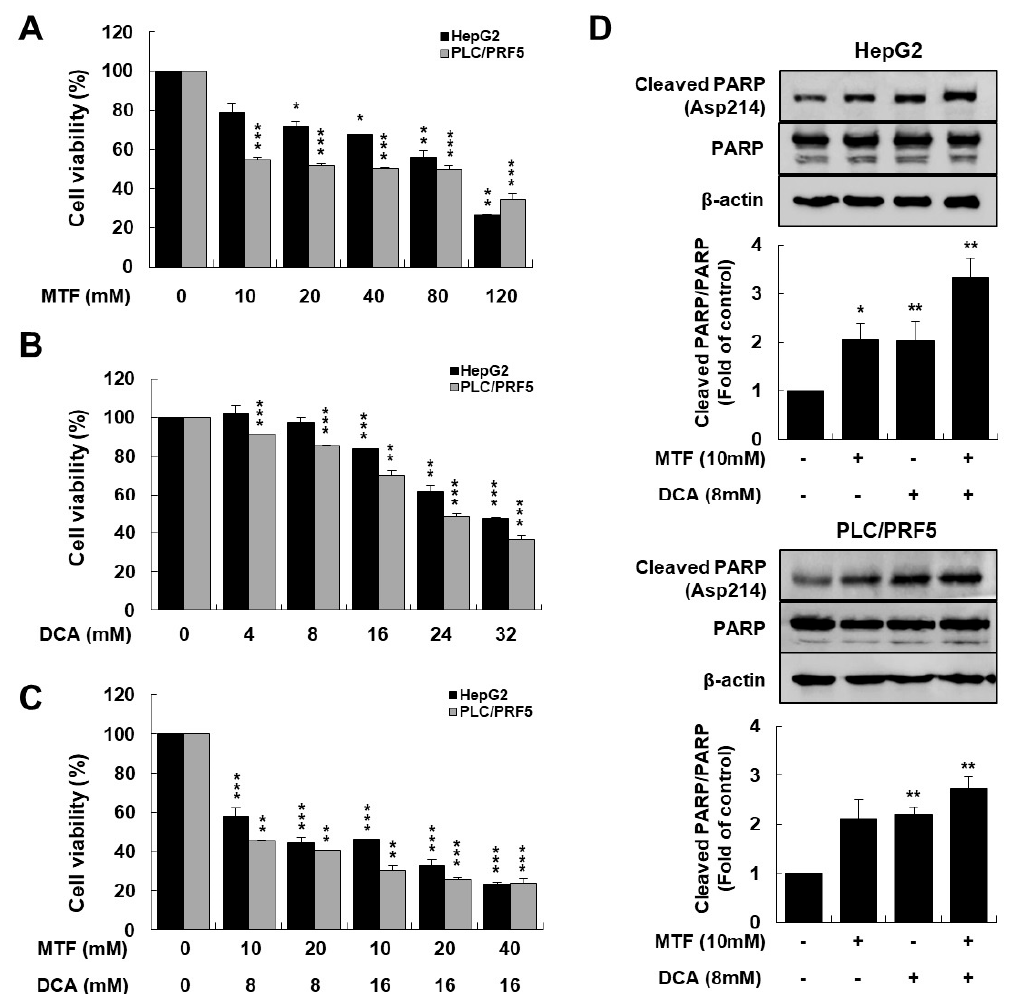
Figure 1. Metformin and DCA effectively induced apoptosis in liver cancer cells. HepG2 and PLC/PRF5 cells were treated with the indicated concentrations of metformin and DCA for 24 h. ( A ) Cytotoxicity of metformin on liver cancer cells significantly increased at a higher concentration compared to the control. ( B ) Cytotoxicity of DCA on liver cancer cells significantly increased at a higher concentration compared to the control. ( C ) Cytotoxicity of metformin and DCA on liver cancer cells significantly increased at higher concentrations compared to the control: the combination index values for the combination of metformin and DCA were 0.63 and 0.58 for HepG2 and for PLC/PRF5 cells, respectively. ( D ) Expression of cleaved PARP significantly increased when liver cancer cells were treated with metformin and DCA compared to each treatment alone. The bottom panel shows relative band density. * p < 0.05; ** p < 0.01; and *** p <